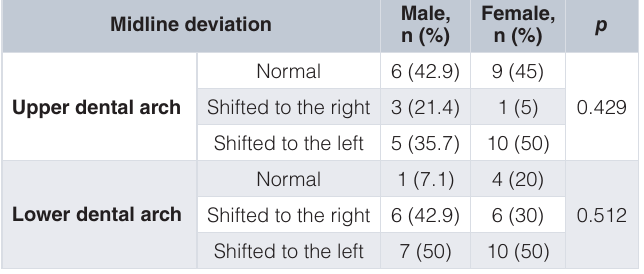
Table 5. Correlation of midline deviation in upper and lower dental arch in in condylar hyperplasia patients. Lower arch Dental Arch Asymmetry Normal Shifted to the right Shifted to the left Normal